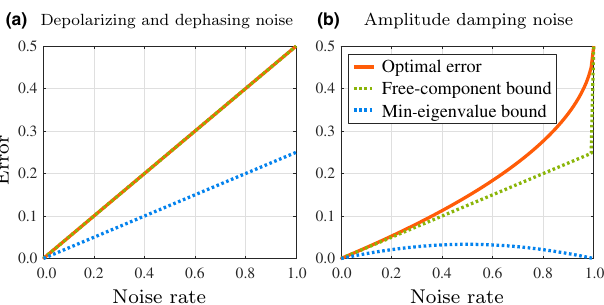
FIG. 2. Comparisons between the optimal achievable error of a standard purification task and the lower bounds induced by (cid:3) (this work) and λ min (Ref. [12]) in coherence theory. The task is to recover the maximally coherent qubit state |+(cid:10) under typi- cal noise channels: (a) depolarizing and dephasing; (b) amplitude damping. The green and blue dashed lines are, respectively, the free component and min-eigenvalue lower bounds on the error, and the red line is the minimum error achieved by MIO computed by SDP Eq. (19). In (a) the green dashed line actually overlaps with the red line, indicating that the free-component error bound is